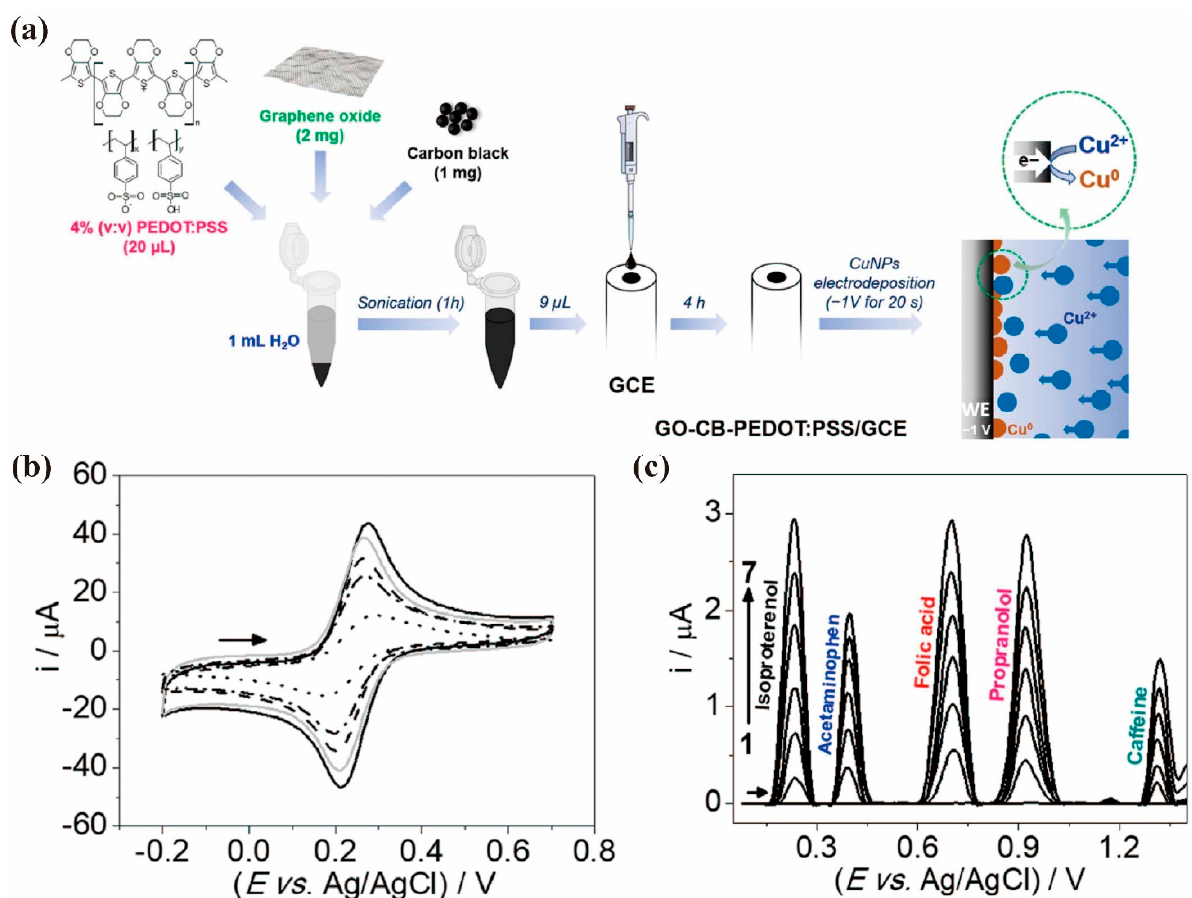
Figure 5. ( a ) Scheme of the fabrication of CuNPs/CB-GO-PEDOT:PSS/GCE electrode; ( b ) Cyclic voltammograms obtained by using unmodified GCE ( ….. ), PEDOT:PSS/GCE ( — · — ), GO-PEDOT:PSS/GCE ( — — ), CB-GO-PEDOT:PSS/GCE ( —— ) and CuNPs-CB-GO-PEDOT:PSS/GCE ( —— ); ( c ) Square-wave voltammograms of the response to diverse analytes obtained on a CuNPs/CB-GO-PEDOT:PSS/GCE [57].